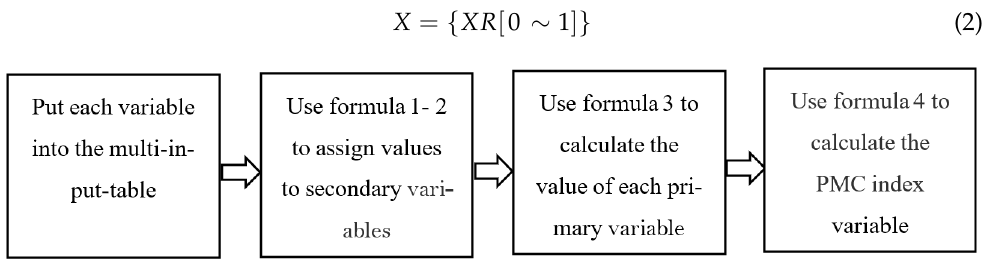
Figure 3. PMC index calculation process.